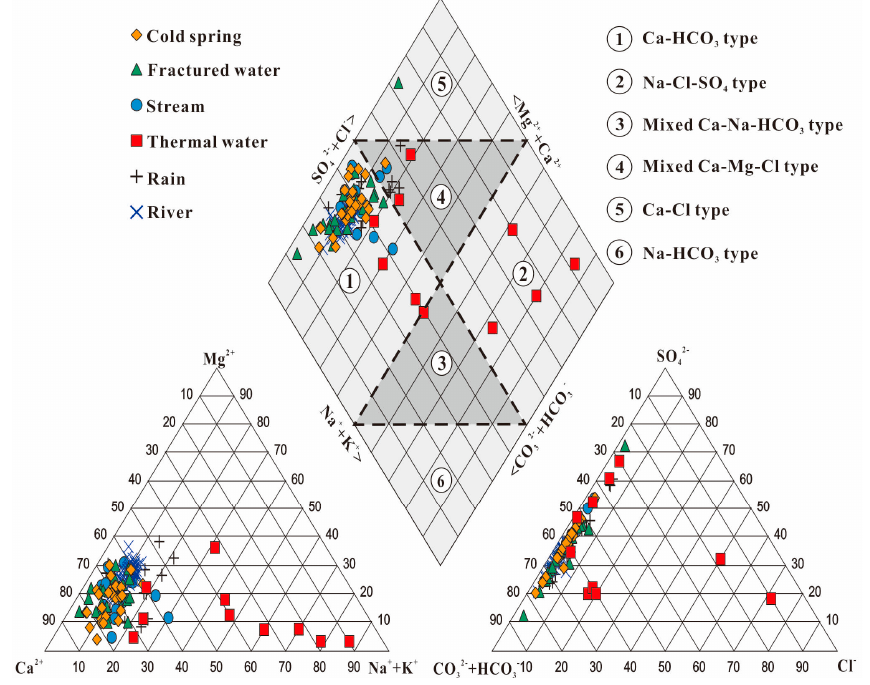
Figure 4. Piper plot of water samples.